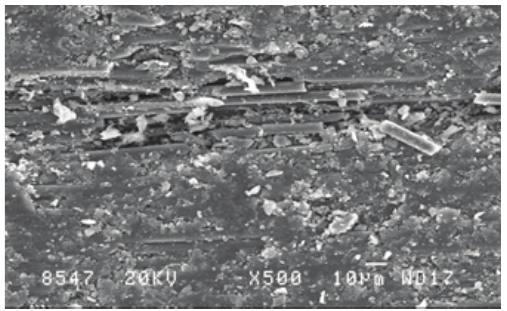
Figure 14: SEM of worn surface of 7.5 SiO 2 G-E